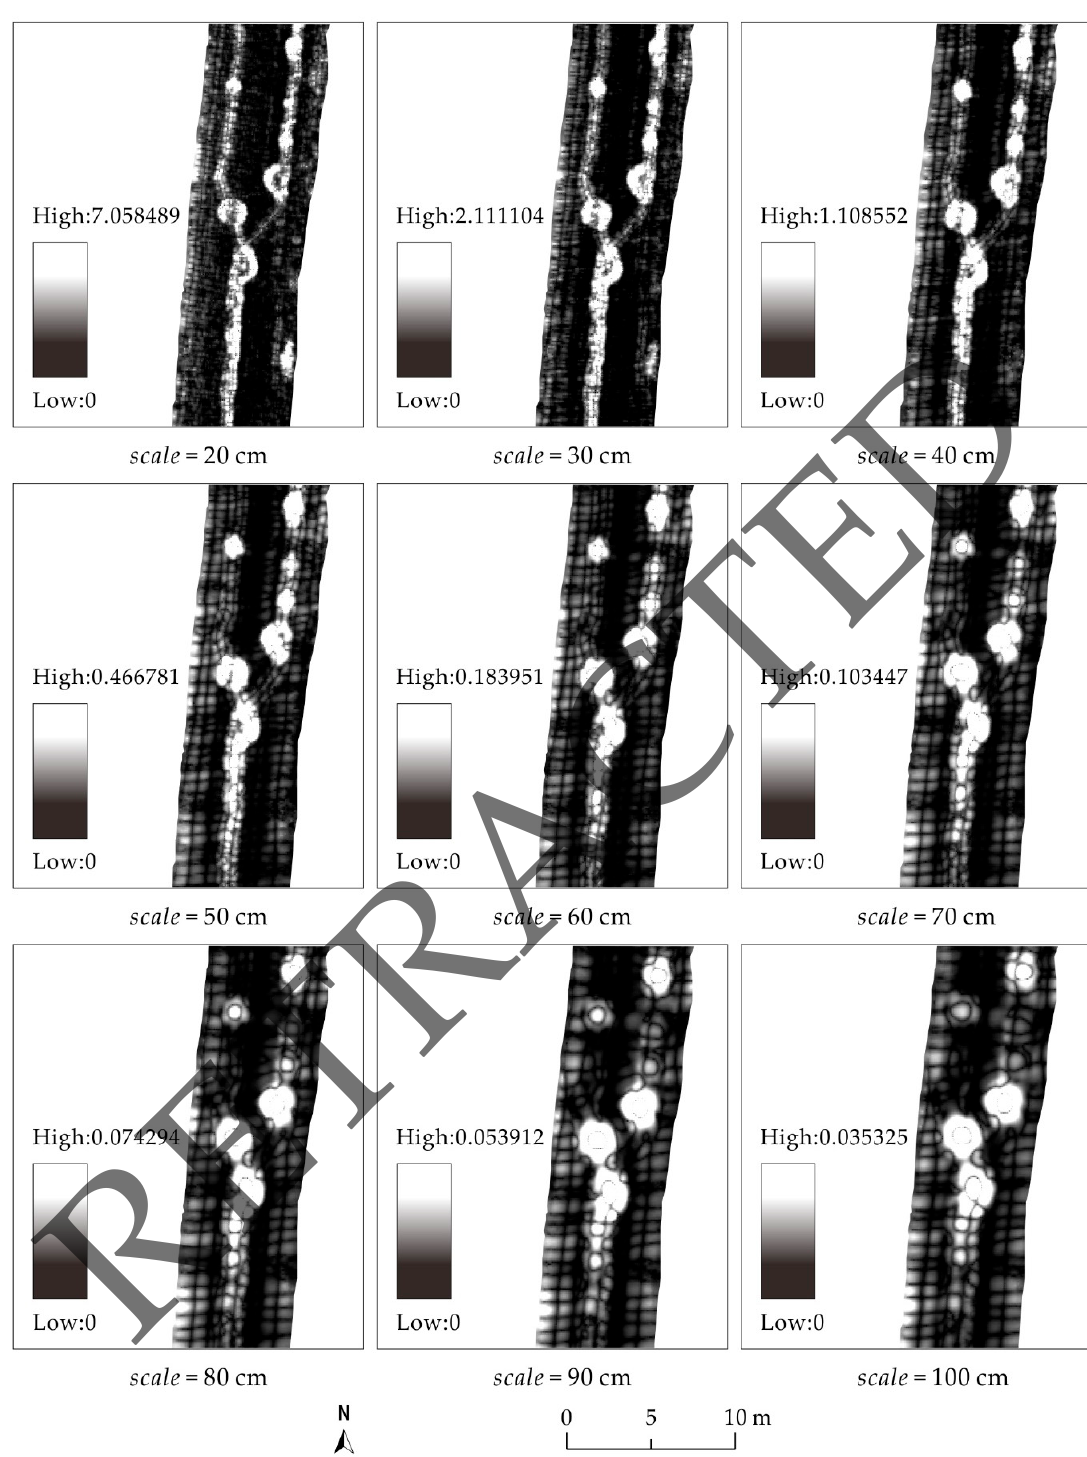
Figure 10. Distribution of Gaussian curvature on microscopic scales.